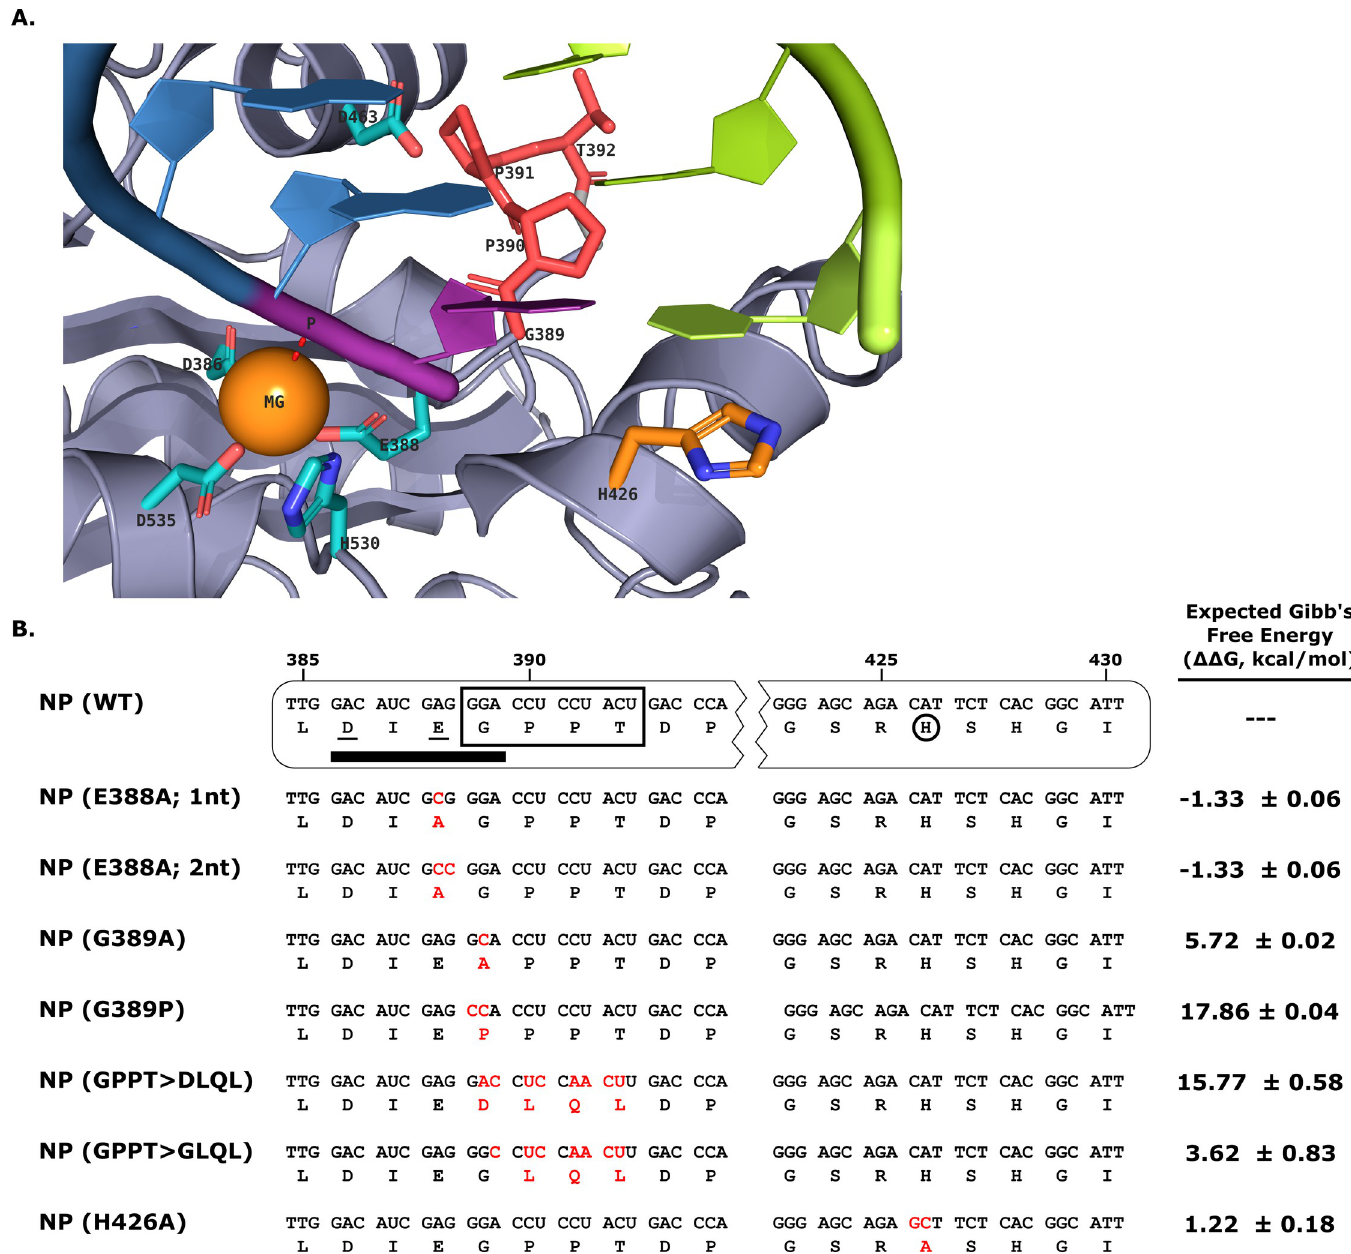
Fig 1. Construction of TCRV nucleoprotein NP exonuclease mutants. (A) Structural model of the TCRV NP exonuclease active site. A homology model of the TCRV NP C-terminal domain (PDB: 4GVE) based on the structure of the LASV NP CTD bound to dsRNA (PDB: 4VFU) is shown. Residues critical for exonuclease activity are shown in stick representation. Active site residues (DEDDh) are depicted in cyan and coordinate a divalent cation (shown here as Mg 2+ , orange). A GPPT sequence forming a flexible loop next to the active site is shown in red. The RNA substrate strand is colored in blue with the 3’-nucleotide to be cleaved in purple. The non-target strand of the substrate dsRNA (shown in green) stays associated with the target strand inside of the active site and interacts with the H426 residue via a base-stacking interaction. ( B) Sequence of TCRV NP mutants and assessment of their predicted impact on folding. A sequence excerpt highlighting mutations (shown in red) in putative exonuclease mutants of TCRV NP constructed for this study. Residues that are part of the DEDDh exonuclease active site (i.e. D386 and E388) are shown underlined, the DIEG(R) motif associated with IKK ε binding and inhibition of IRF3 activation is indicated by a black bar, and the H426 residue associated with non- template strand RNA-binding is circled. A flexible loop sequence located next to the exonuclease active site that is reported to be mutated from GPPT to DLQL by a pair of frameshift mutations in some TCRV isolates is shown boxed. The expected change in Gibb’s free energy ( ΔΔ G) is shown for each mutant relative to wild-type.